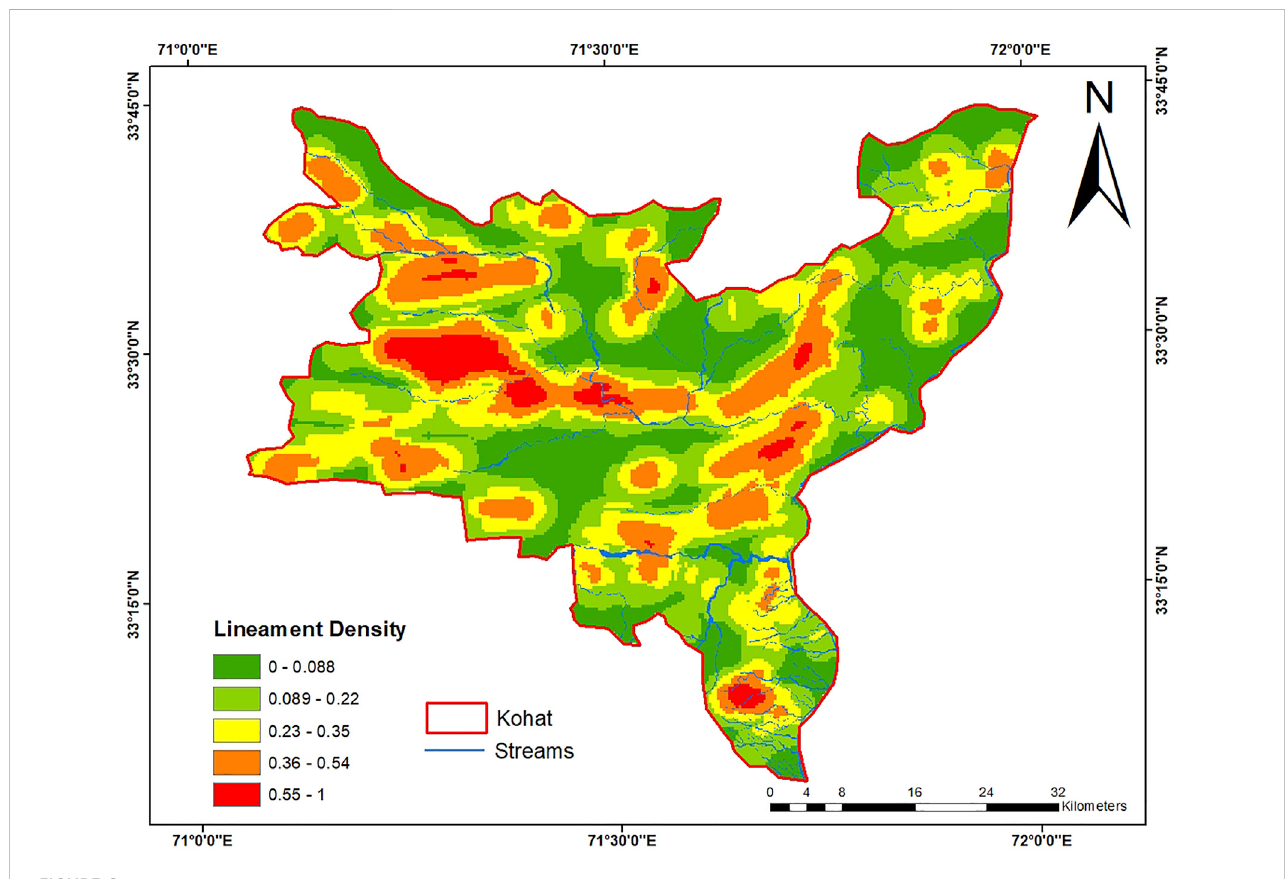
FIGURE 6 Lineament map of the study